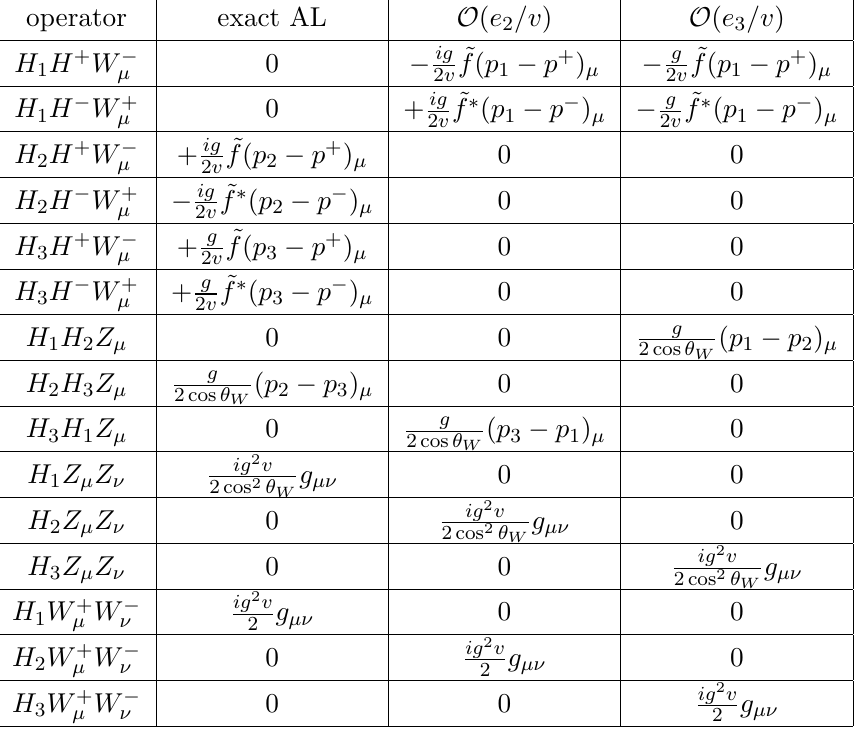
, H i H (cid:0) W + , H i H j Z (cid:22) , H i Z (cid:22) Z (cid:23) and H i W + (cid:22) (cid:22)